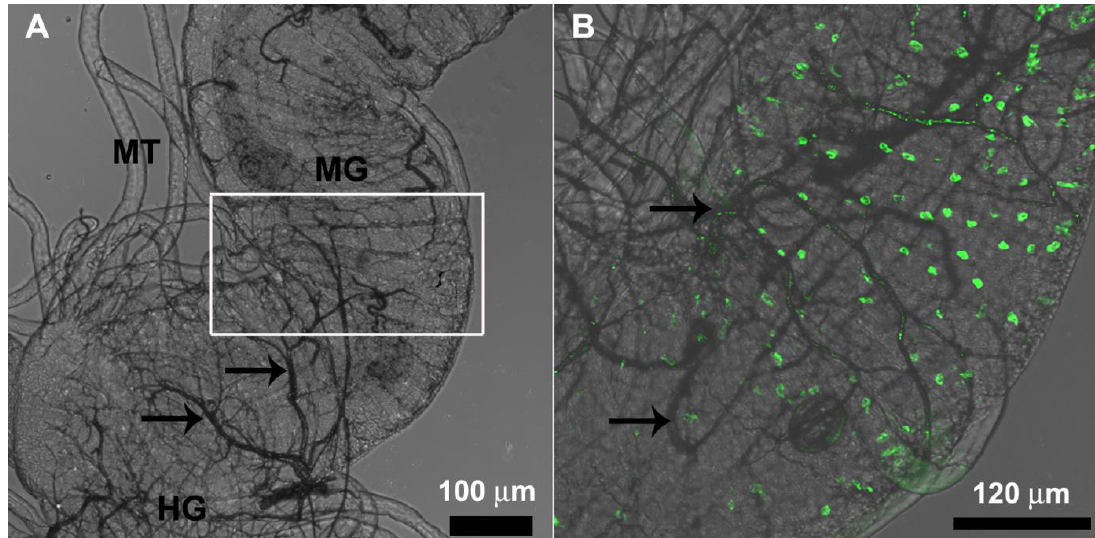
Figure 8. Morphometry of the midgut epithelium of Friesella schrottkyi worker. ( A ) Epithelium thickness (mean ± sd) in the anterior and posterior midgut regions. ( B ) Length (mean ± sd) of the striated border of the digestive cells in the anterior and posterior midgut regions. Different letters onto bars show differences between anterior and posterior midgut regions at 5% of significance level.